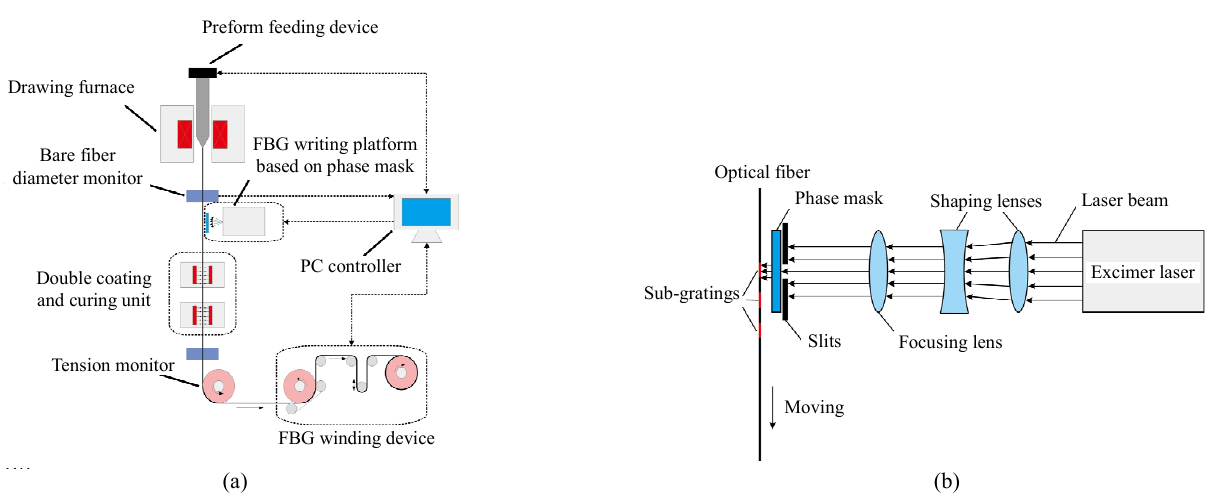
Fig. 1 Schematic diagram of (a) the FBG drawing tower in-line writing system and (b) the writing platform.